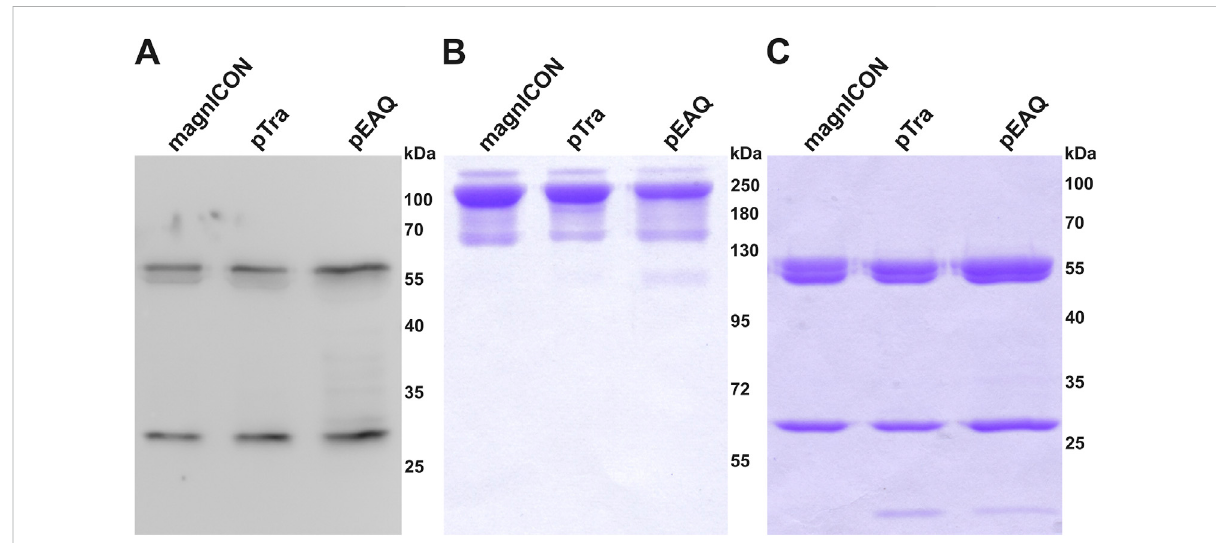
FIGURE 1 Expression and puri fi cation of Cetuximab (Cx). (A) Western blot analysis of total soluble protein extracted from WT plants in fi ltrated with magnICON-, pTra- and pEAQ-Cx (extracts were concentration-adjusted according to Cx yield to achieve comparable signal intensities); (B) SDS- PAGEofpuri fi edmagnICON-,pTra-andpEAQ-Cxundernon-reducing,and (C) reducingconditions.3.5 μ gIgG1wasloadedineachlaneinboth (B) and (C) .HCdoublebandsrepresentglycosylatedandnon-glycosylatedportionsofthemAbs(Castilhoetal.,2018).Low-molecularbandsin